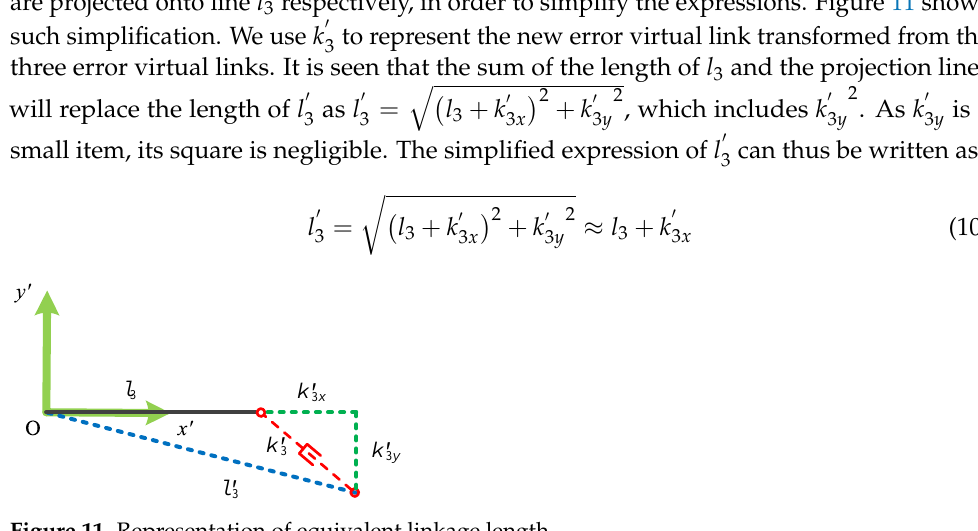
Figure 11. Representation of equivalent linkage length.